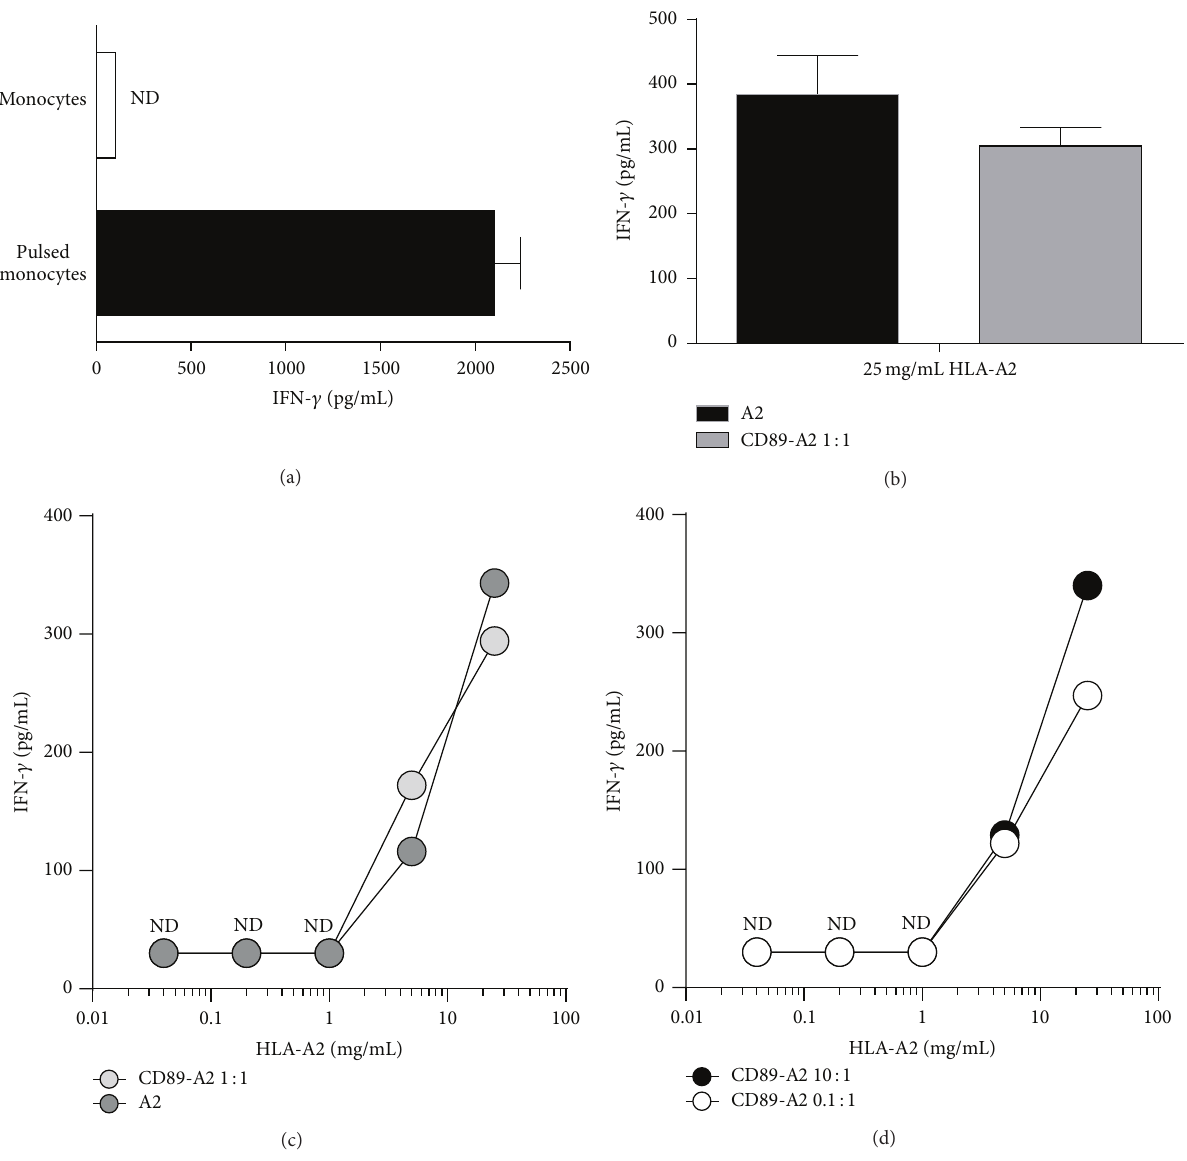
Figure 3: HLA-DR mediated antigen presentation by monocytes is not enhanced through CD89-targeted endocytosis. (a) HLA-DR1+/HLA- A2 − monocytes were either pulsed (dark bar) or not (light bar) with HLA-A2 peptides and cocultured with T-cell clone. After 24h incubation supernatants were harvested and IFN- 𝛾 was measured. (b) CD89-A was incubated at a ratio of 1:1 with biotinylated HLA-A2 monomer for 2 hours (CD89-A2), before they were added to the monocytes for 4 hours and then washed. T-cells were then added and IFN- 𝛾 measured. In comparison monocytes were also incubated with HLA-A2 alone (A2). ((c) and (d)) Different ratios of CD89 and A2 were used as explained in (b) and titrated. All experiments were performed at least 3 times; shown is the mean with SD of one experiment in triplicate except for (a) and (b) where the mean of 3 experiments in triplicate is shown with SD. ND: